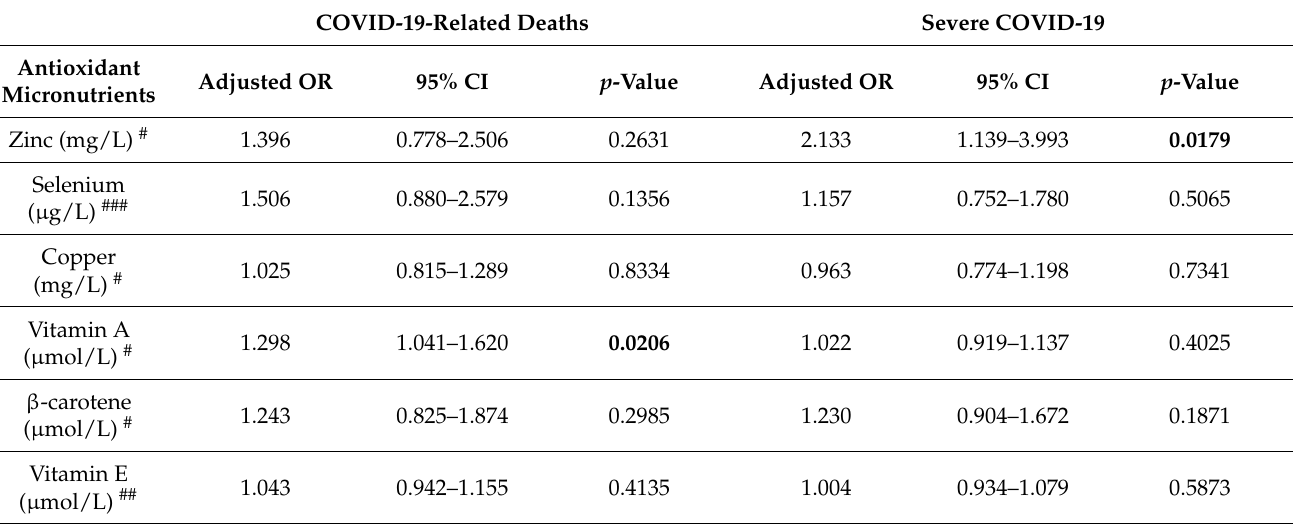
Table 4. Multivariate logistic regression analysis of the association between plasma micronutrients levels and COVID-19-related deaths and severe forms (adjusted on age, sex, CRP, albumin, BMI and vitamin D supplementation) in the 94